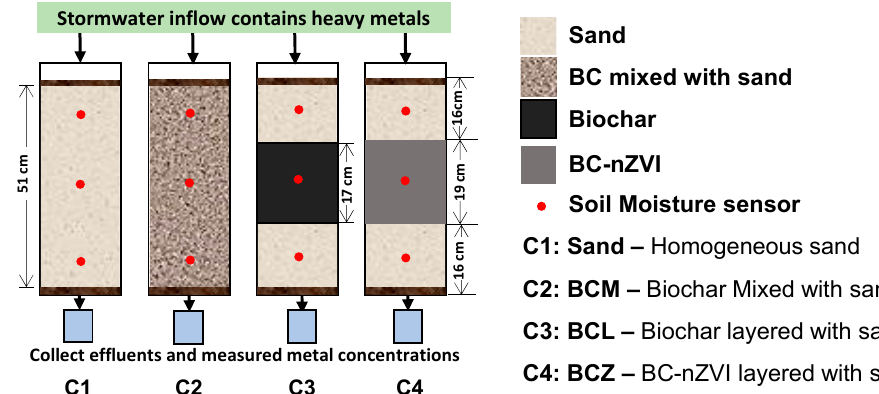
Figure 1. Column media with sand, biochar, and nZVI modified biochar (BC-nZVI) in four different configurations. Each column configuration was triplicated in the experiment.